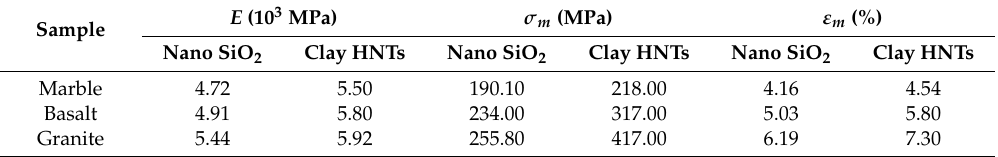
Table 2. Effect of nanoparticle type on the flexural strength properties of PMMA/SSF nanocomposites. Sample